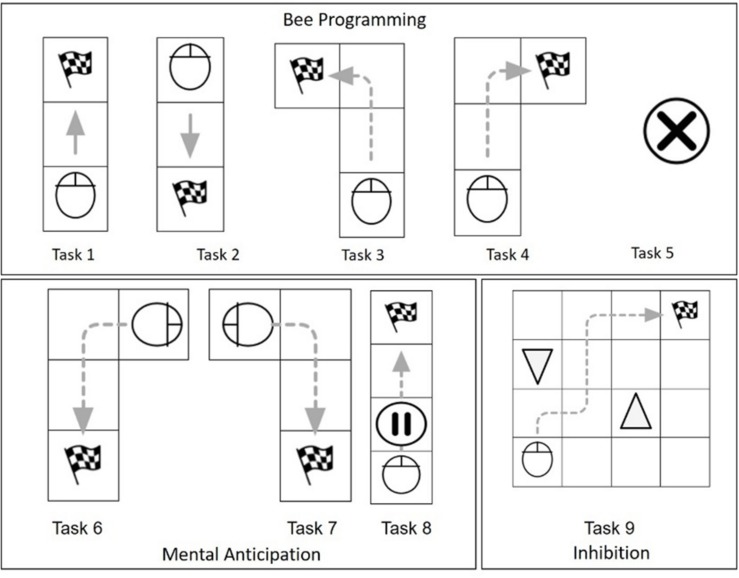
The ER-Lab test.